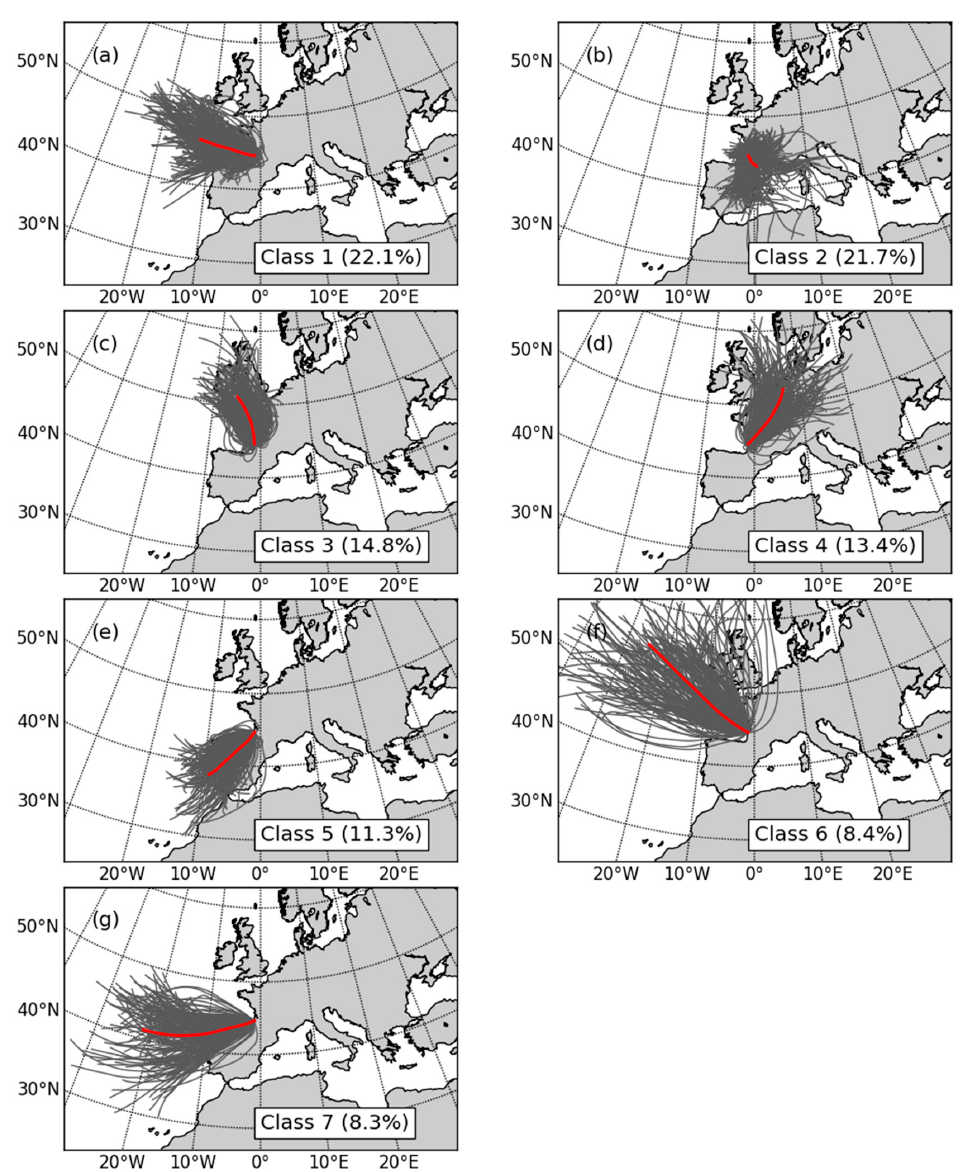
Figure 7. The whole set of the three-day trajectories ending at the Arcachon lagoon at an altitude level of 1000 m obtained for: ( a ) class 1; ( b ) class 2; ( c ) class 3; ( d ) class 4; ( e ) class 5; ( f ) class 6; and ( g ) class 7. The centroid of each class is indicated by a red curve and the percentage of air mass back trajectories associated with each class is given in brackets.